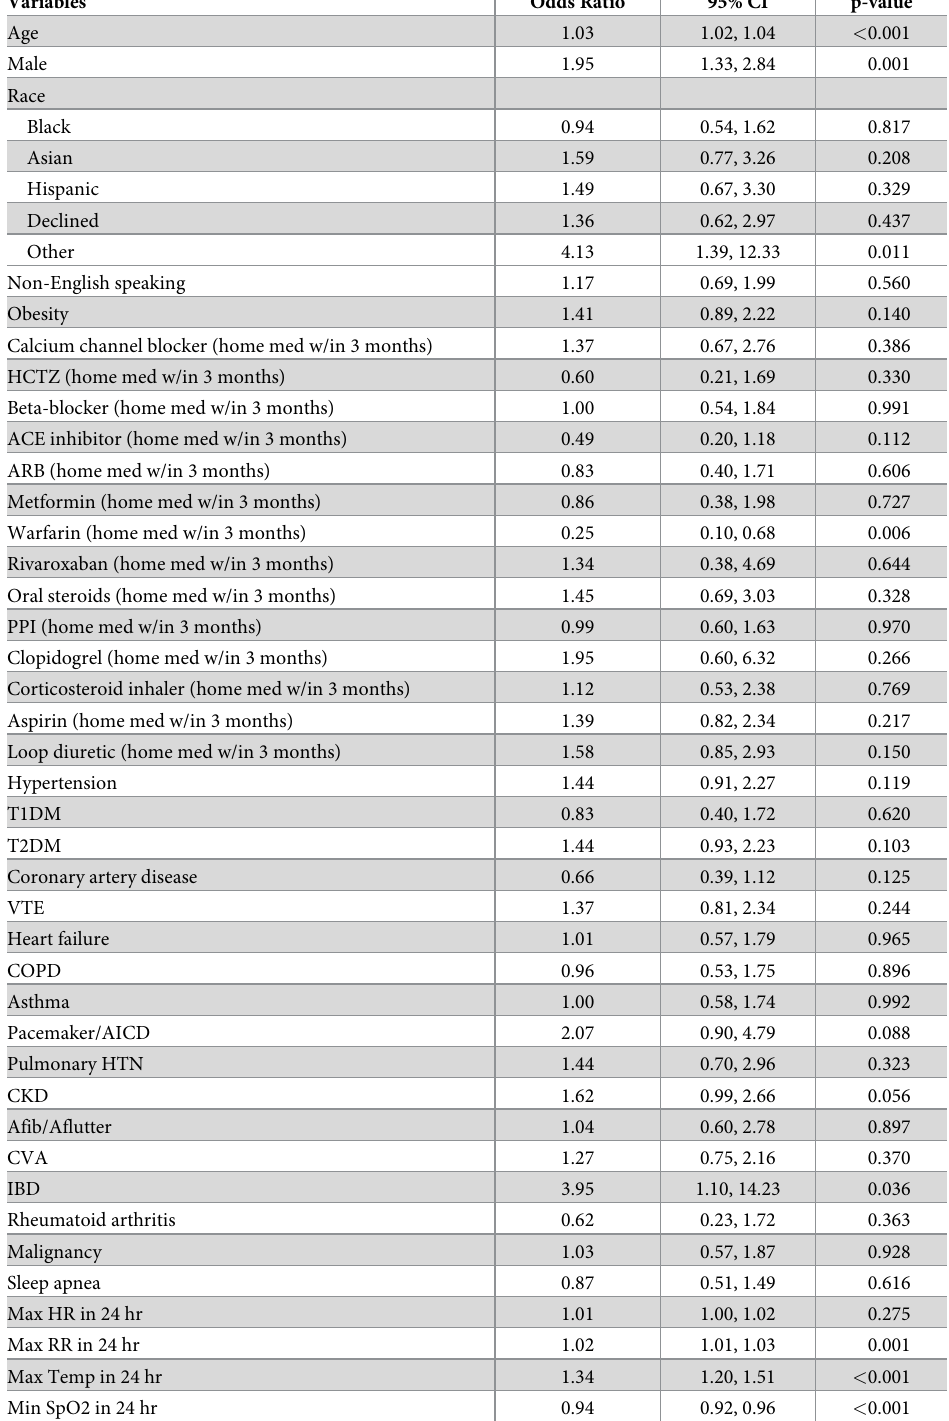
Table 2. Odds ratios of variables in the